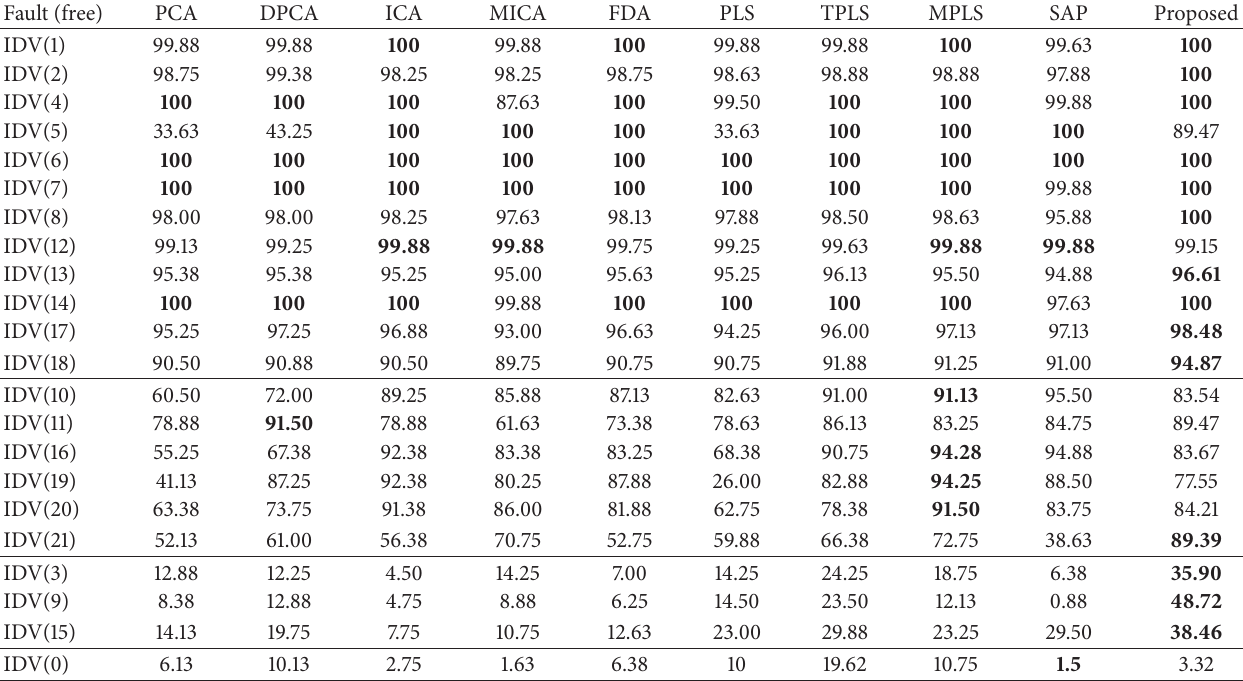
Table 1: FDRs (%) and FARs (%) comparison with classical PM-FD methods on TE data sets given in